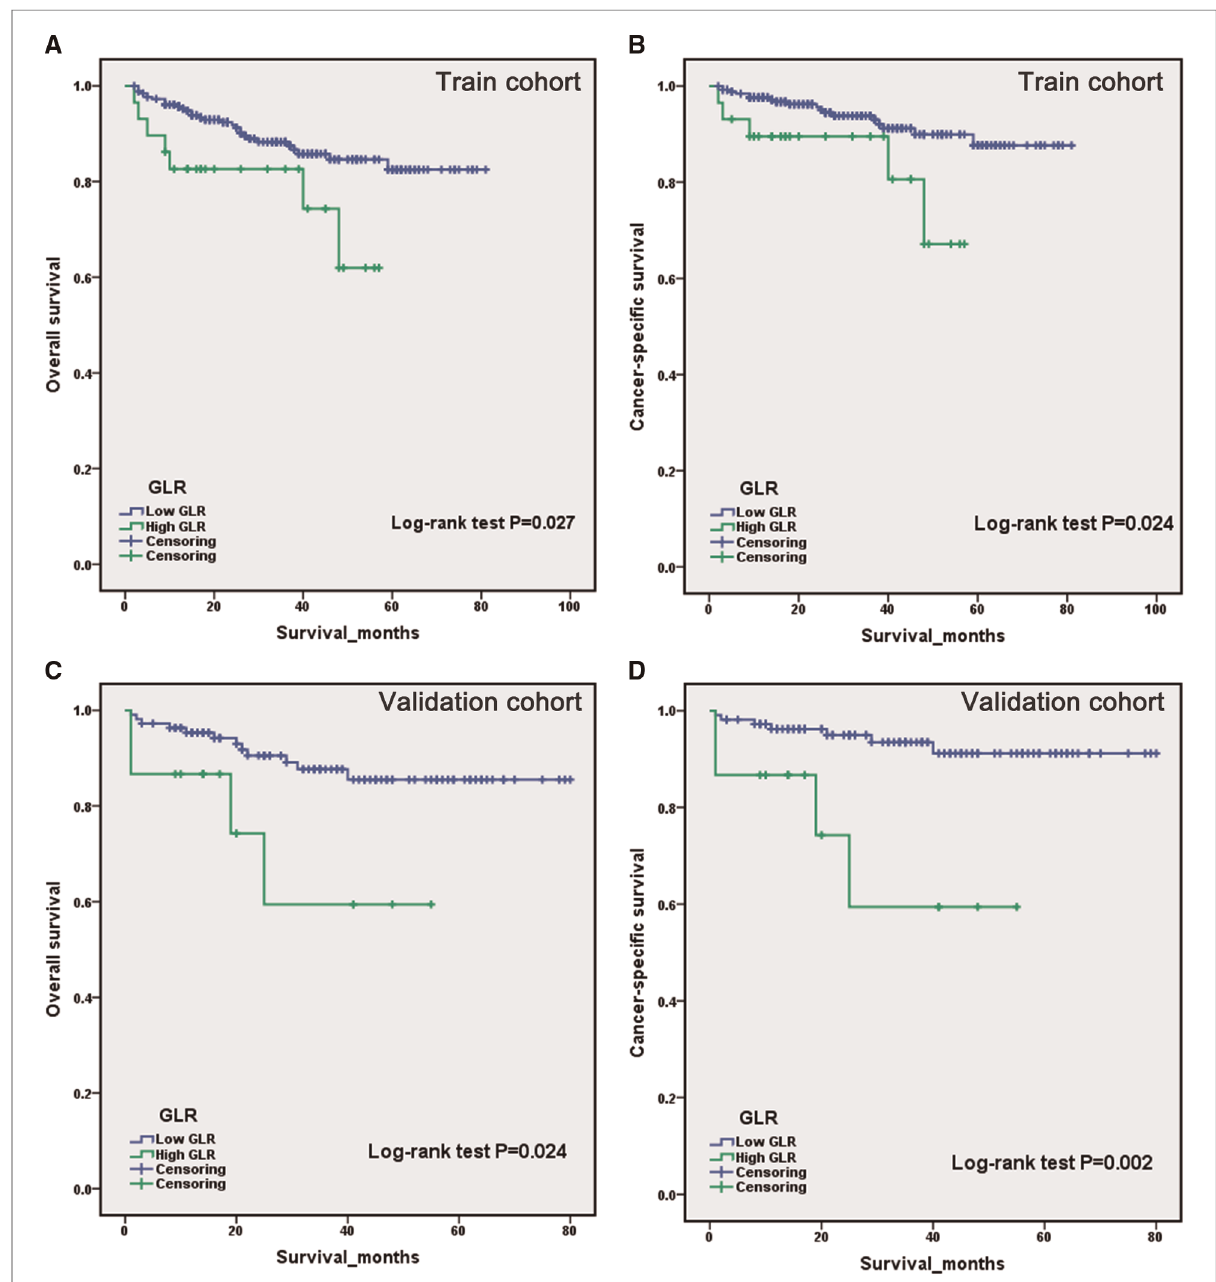
FIGURE 1 Kaplan-Meier curves for overall survival and cancer-speci fi c survival of patients with renal cell carcinoma after laparoscopic nephrectomy in the train cohort ( A,B ) and validation cohort ( C,D ), strati fi ed by glucose to lymphocyte